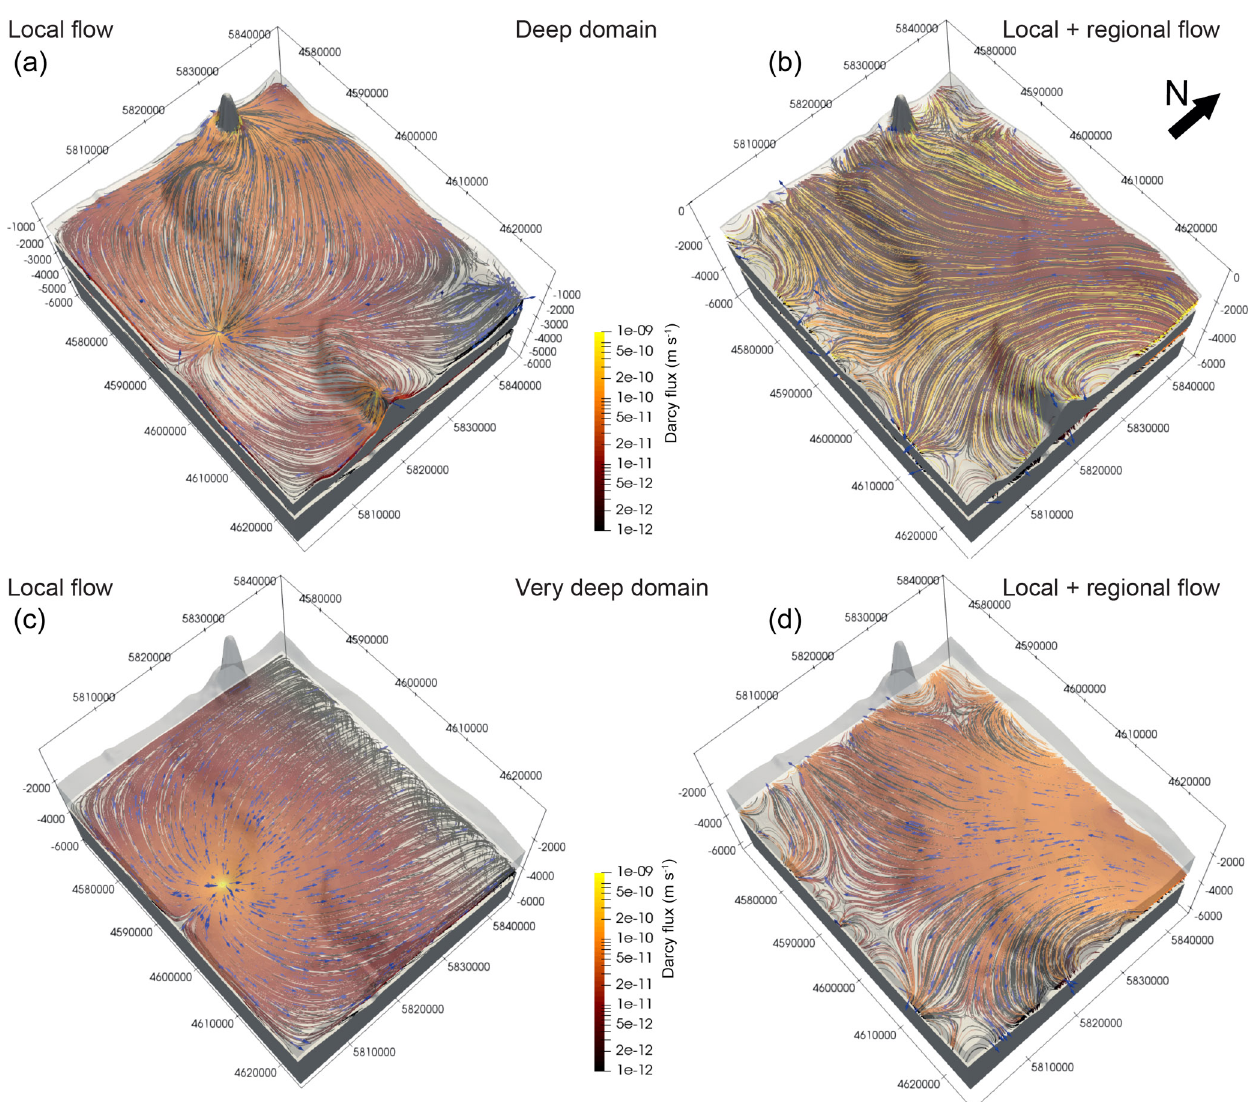
Figure 3. 3-D view of the flow dynamics at different depth levels. (a, b) Deep domain (below Middle Muschelkalk, above Zechstein), (c, d) intermediate domain (below Zechstein, above Basement). Coloured flow lines represent preferential flow directions and magnitude of Darcy velocity. Blue arrows represent flow directions. Calculated with Paraview’s stream tracer filter (Squillacote et al., 2007); Gray layers from top to bottom: Middle Muschelkalk, Zechstein, Basement. Coordinates [m] in Gauß-Krüger DHDN Zone